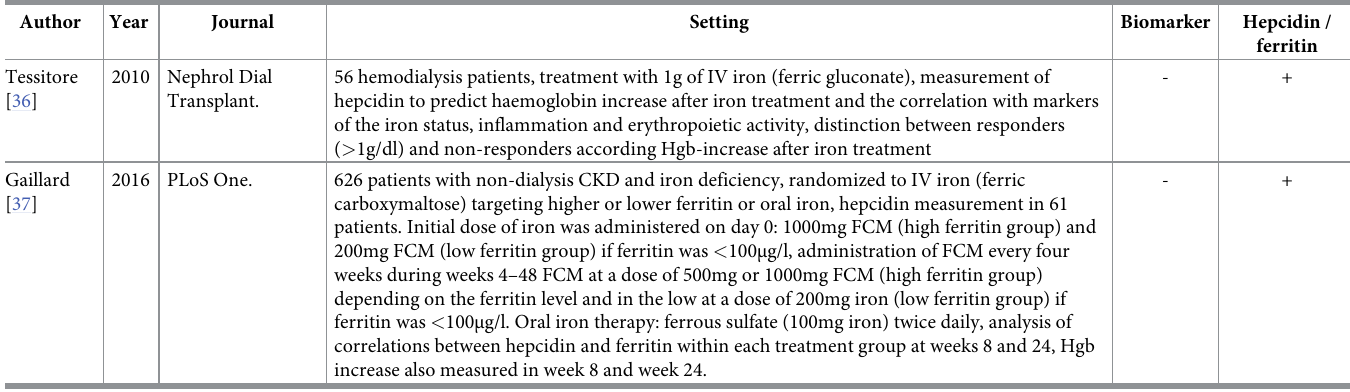
Table 5. Two studies that analyzed hepcidin as a potential biomarker and/or the correlation between hepcidin and